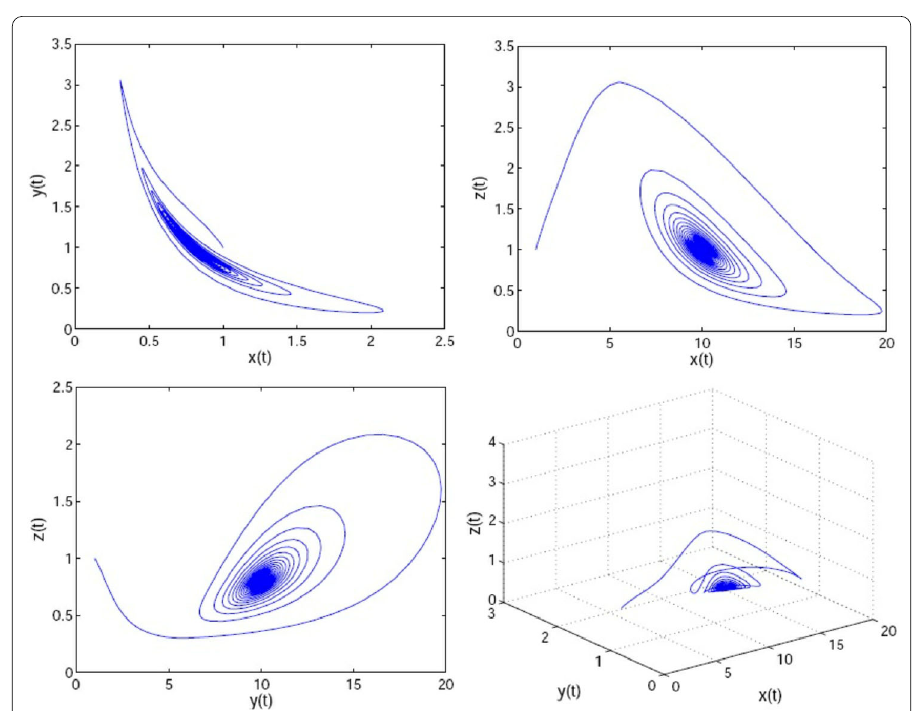
Figure 6 The phase plots of system (32). It is asymptotically stable when τ = 5.8 < τ 0 = 6.153